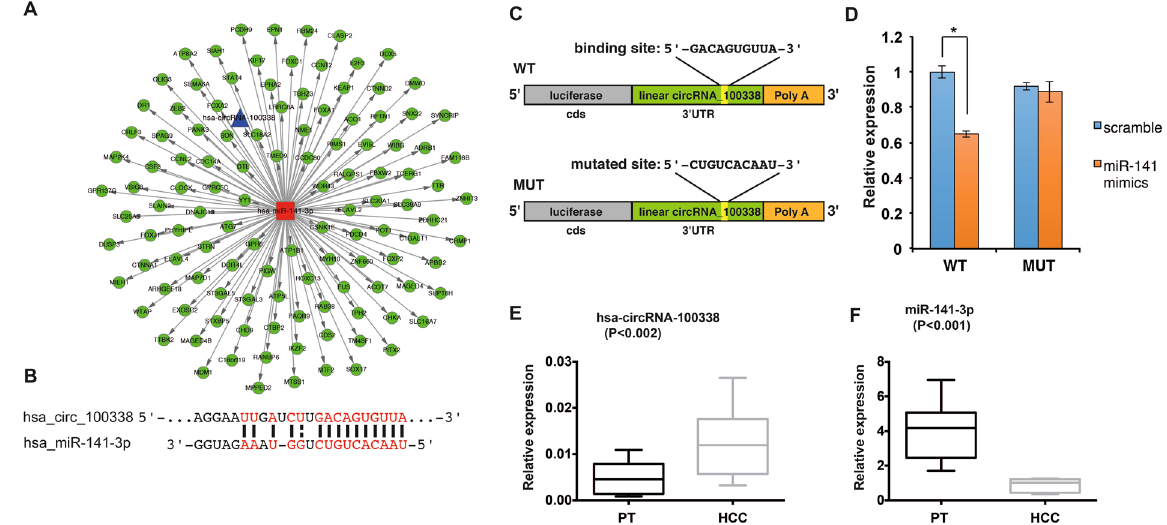
Figure 4. circRNA_100338 interacts with miR-141 in HCC. ( A ) A biomathematically predicted miRNA-target network for hsa-miR-141-3p. This network is predicted based on sequence-pairing prediction. miRNA and its predicted target genes are labelled in red and green, respectively. Specifically, circRNA-100338 is also indicated as a target (presented in blue). ( B ) Sequence base-paring between circRNA_100338 and miR-141-3p. Note that the seed region is fully complementary to the sequence of circRNA_100338. ( C ) Schematic of luciferase reporter genes. Linearized circRNA_100338 sequence with a wild-type (WT) or mutated (MUT) miR-141-3p interaction site was fused into the 3 ′ UTR of the luciferase gene. ( D ) The luciferase reporter assay indicated that circRNA_100338 directly interacts with miR-141-3p at the predicted interaction site in a human cellular context. Assays were performed using either miR-141 mimic (orange) or scramble RNA control (blue). ( E ) Further verification of circRNA_100338 expression in HCC and paired pericancerous tissues (PT) using qRT- PCR ( n = 10). ( F ) Verification of miR-141-3p expression in HCC and paired pericancerous tissues (PT) samples ( n = 10). n = 3; * P =